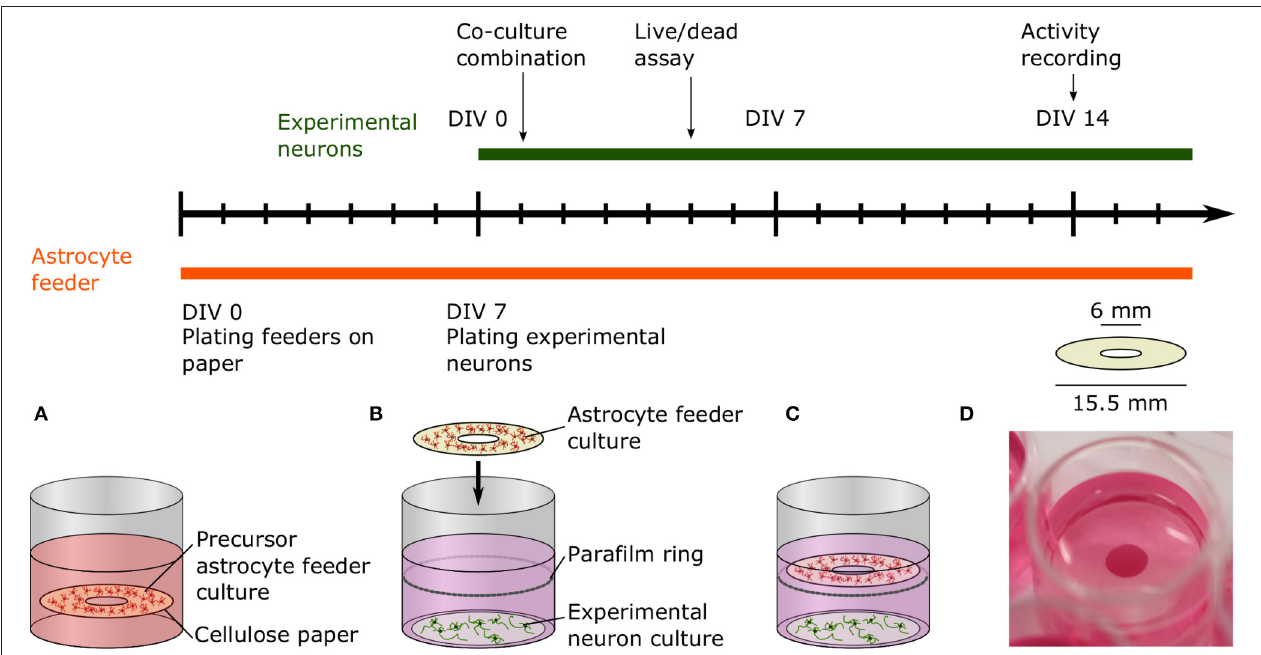
FIGURE 2 | Timeline and schematic of the paper-based co-culture platform supporting low-density neuron cultures. (A) The precursor astrocyte feeders were cultured and proliferated on paper rings in medium supplemented with serum for 1 week before combination with the experimental neuron culture. (B) After a week, freshly dissociated neurons were seeded onto glass coverslips to create the experimental neuron cultures. After 24h, the 8 DIV astrocyte feeder culture was added to the 1 DIV experimental culture. The paper ring was placed on top of a Parafilm ring submerged in the media to prevent direct contact of the two cultures. (C) Viability and neurite length of the experimental neuron culture was measured at 5 DIV with a live/dead assay. The experimental neuron culture activity was assessed at 14 DIV using calcium imaging. (D) Picture of the co-culture platform in a 24-well